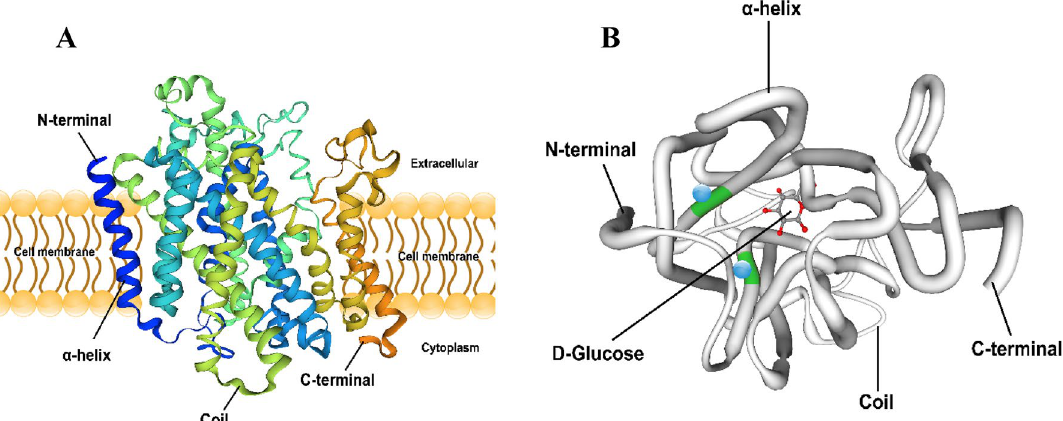
Figure 4. Protein 3D structure prediction of Sglt1 in Megalobrama amblycephala.